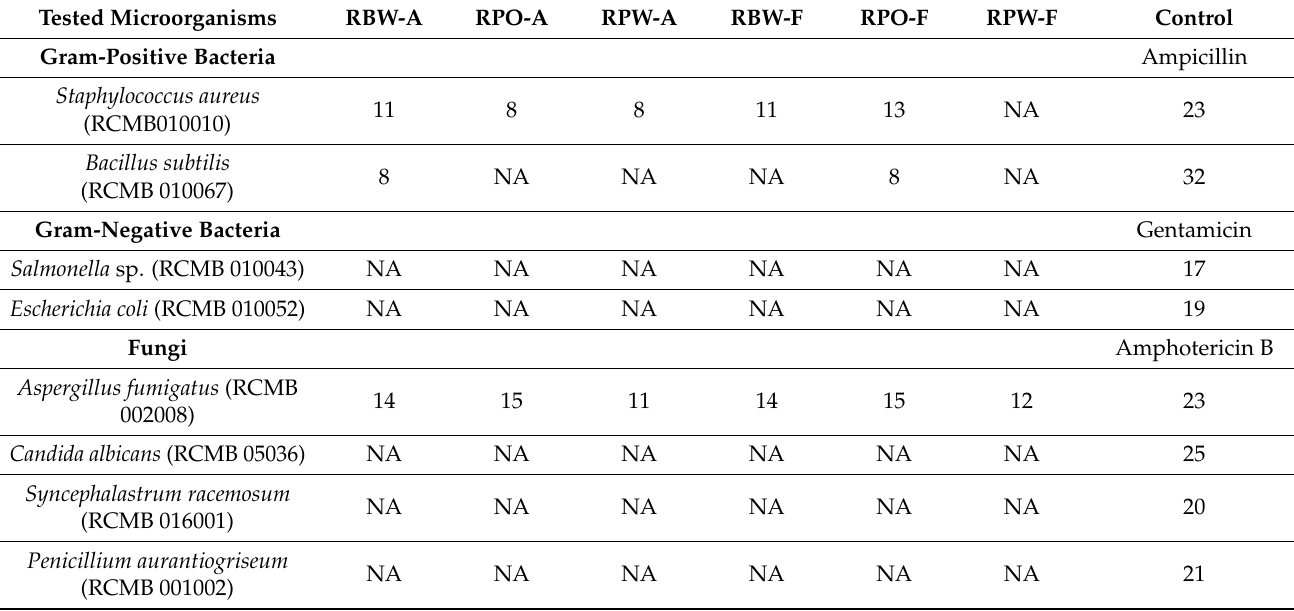
Table 2. Antimicrobial activity of aerial parts and flower volatile oils of Rosa varieties expressed as the diameter of one of inhibition in